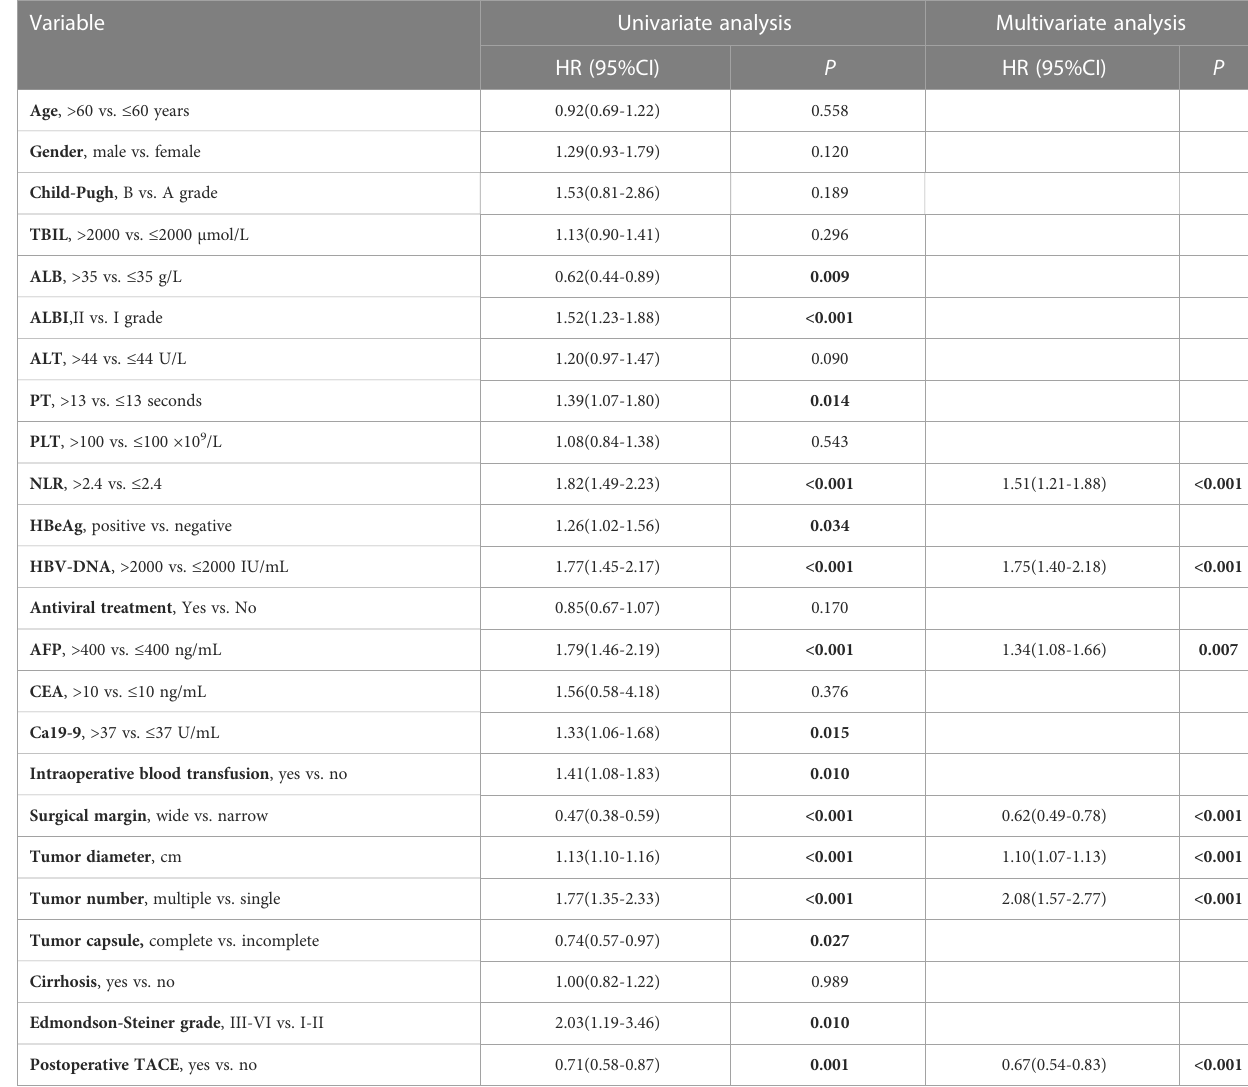
TABLE 2 Univariate and multivariate cox regression analysis of recurrence in the training cohort.